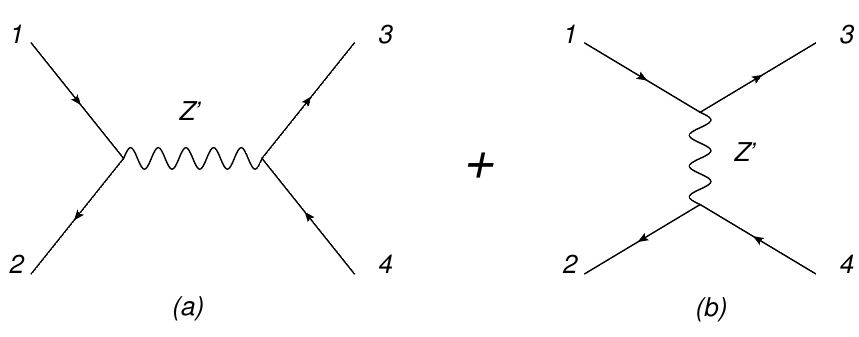
Figure 3 . s- and t-channels contributions to the amplitude for a generic scattering cross